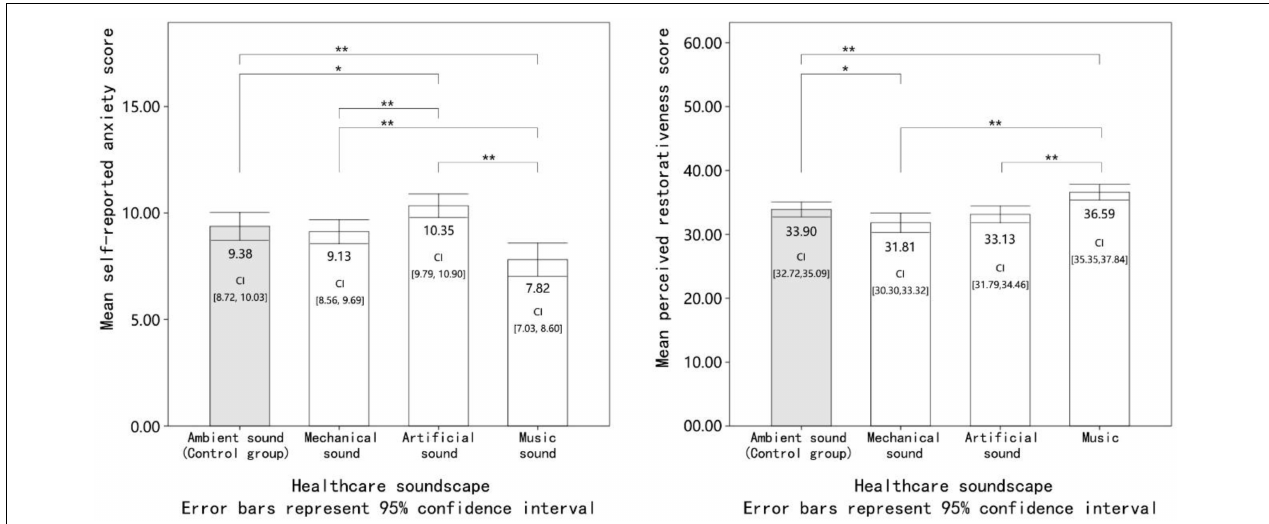
FIGURE 4 | The mean value of patients’ psychological stress recovery indicators under exposure to different healthcare soundscapes. Error bars depict 95% confidence interval. *Significant at the 0.05 level. **Significant at the 0.01 level.